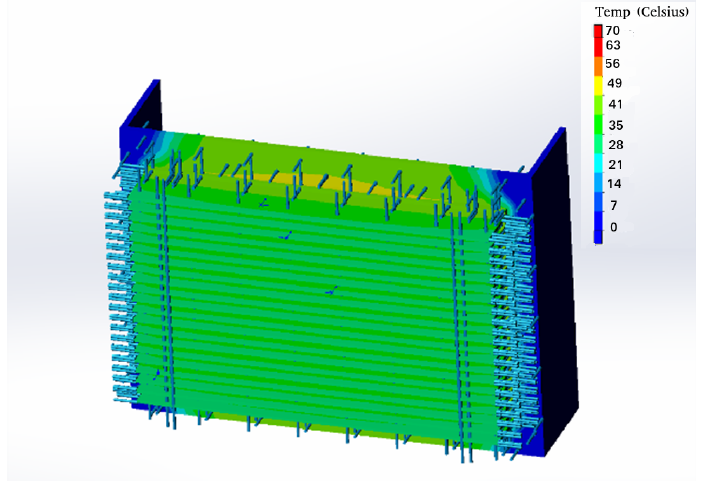
Figure 9. Temperature distribution model for the external side of the control computing unit. The simulation results show the high efficiency of the developed architecture in the distribution of thermal